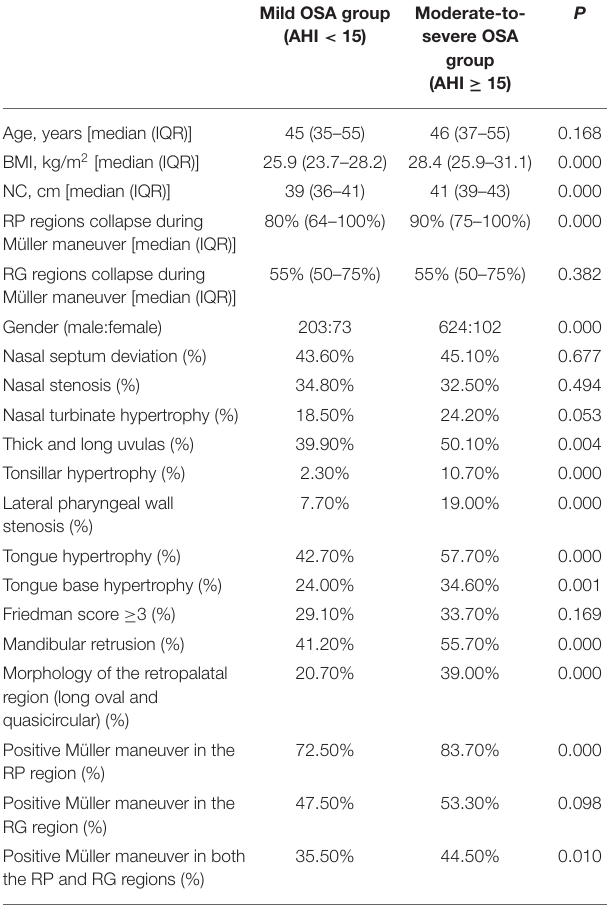
TABLE 1 | Distribution of upper airway narrowing by OSA